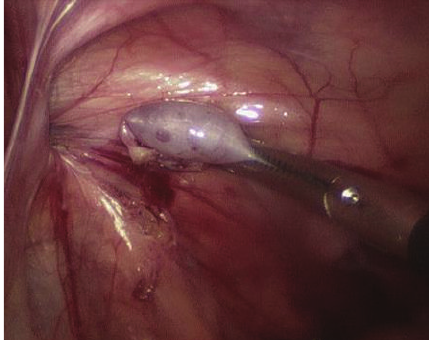
Figure 3: Absence of right vas deferens and epididymis in laparo- scopic